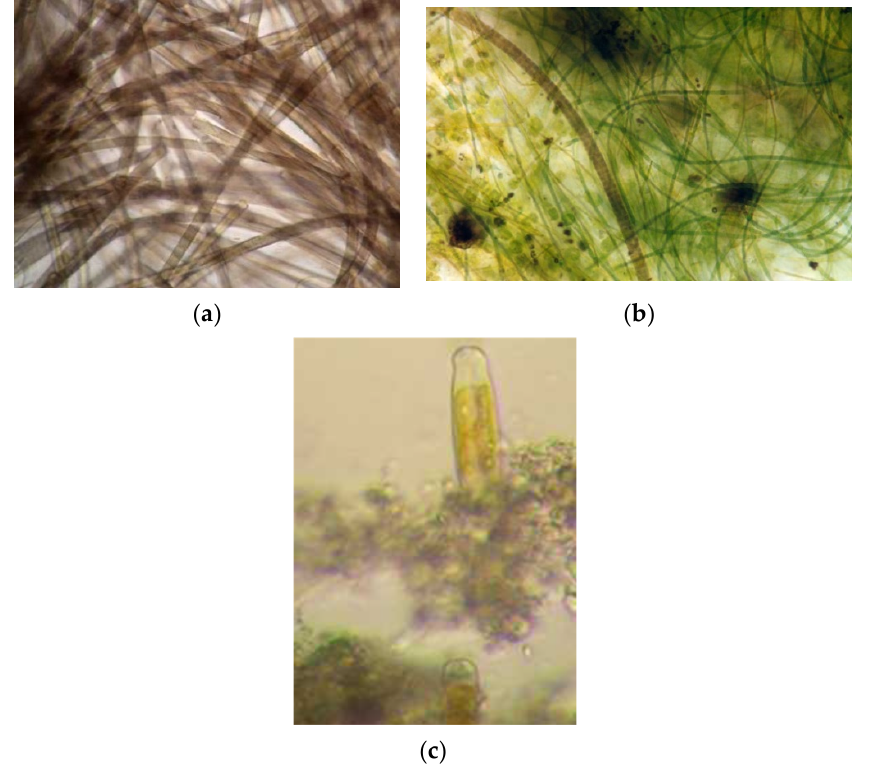
Figure 1. Cyanobacteria species composition. ( a ) Oscillatoria sp. from a floating mat; ( b ) green film dominated by Spirulina cf. labyrinthiformis and Leptolyngbya sp. a brown filament of Oscillatoria sp. is also visible; ( c ) Diatoms ( Pinnularia sp.) growing on the surface of the mud in maturation. In this ecosystem cyanobacteria appear to adopt two different strategies to protect cells from the high irradiances in the summer. In the mat dominated by Oscillatoria filaments alternately migrate within the mat and shelter in shaded zones and tend to pack together. This behaviour was previously observed in Oscillatoria terebriformis [34]. In the biofilm dominated by S. cf. labyrinthiformis and Leptolyngbya -like cyanobacterium filaments have less capacity for movement and evade the excess of irradiance mainly by altering their pigment ratio. However, when the Oscillatoria mat floats to the surface, the high irradiance and the increased temperature at the water-air interface can cause degradation of the trichomes during the summer months.